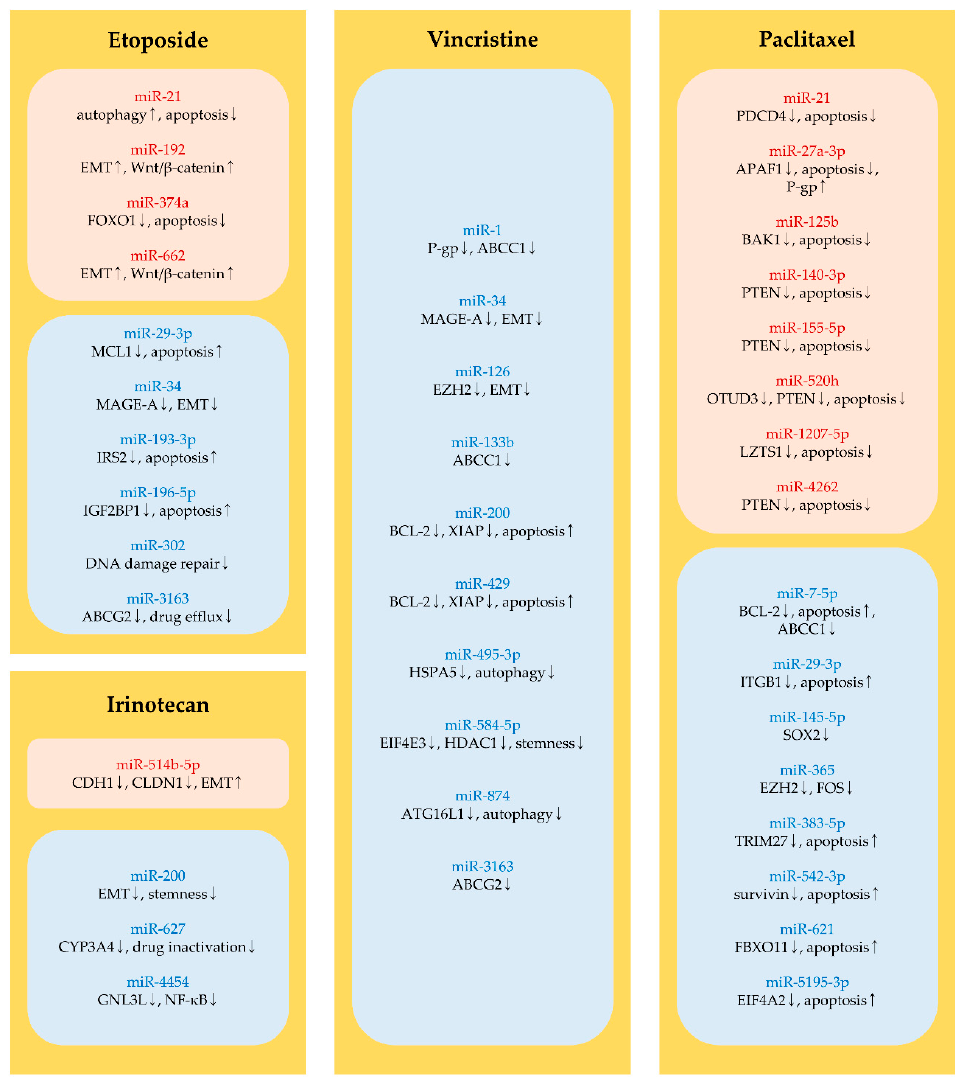
Figure 5. MiRNAs regulating the efficacy of plant-derived anti-cancer agents in cancer. Resistance-promoting and -suppressing miRNAs are indicated in red and blue colors, respectively. It is described in Section 5. Table 6. MiRNAs involving in the regulation of efficacy of plant-derived anti-cancer agents. Phytochemicals (A Type miRNAs of miRNAs